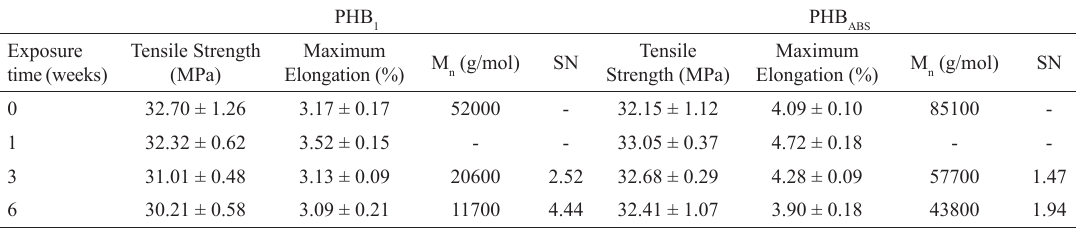
before and after exposure to UV radiation for different times. ABS PHB 1